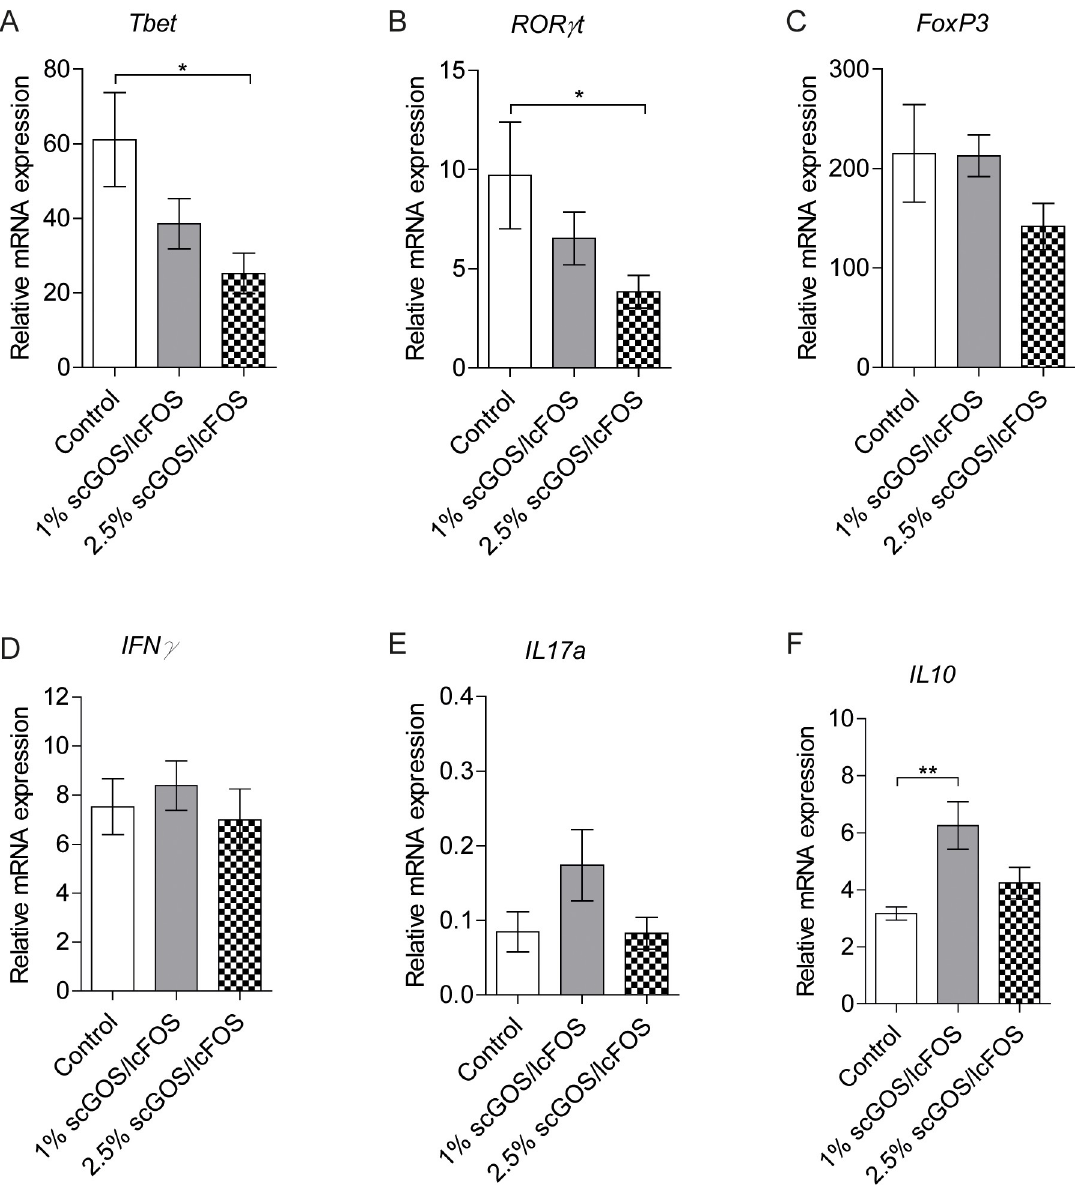
Fig 3. Oral treatment of arthritic IL-1Ra -/- mice with prebiotic scGOS/lcFOS has no effect on T cell subsets during arthritis. (A-B) Gene expression of Tbet (A), ROR γ t (B) and FoxP3 (C) in joint draining lymph nodes of arthritic IL-1Ra -/- mice fed a control diet (n = 5) or a diet containing either 1% (n = 5) or 2.5% (n = 8) scGOS/lcFOS. Relative mRNA expression is shown as 2 - Δ Ct � 10000, corrected for GAPDH. � p < 0.05 by Kruskal-Wallis with Dunn’s post test.